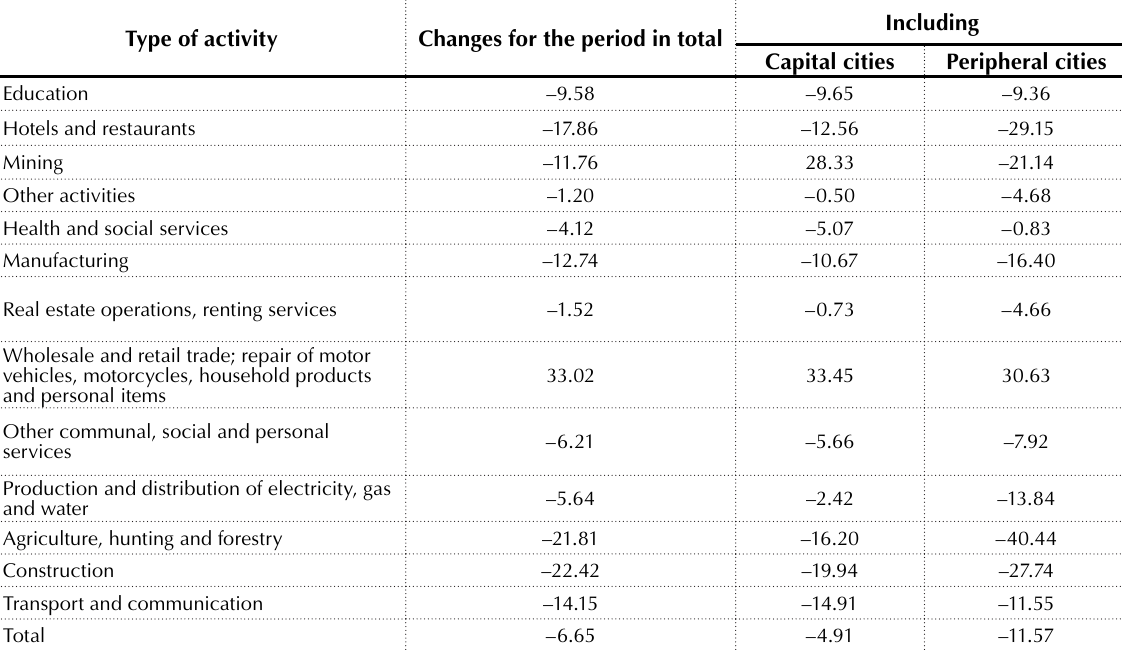
Table 3. Changes in the number of employees in organizations in capital and peripheral cities, 2009–2015,